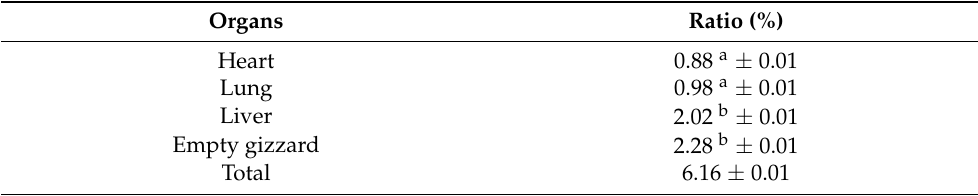
Table 3. Ratio of the main organs expressed in the percentage of live weight ( n = 10).